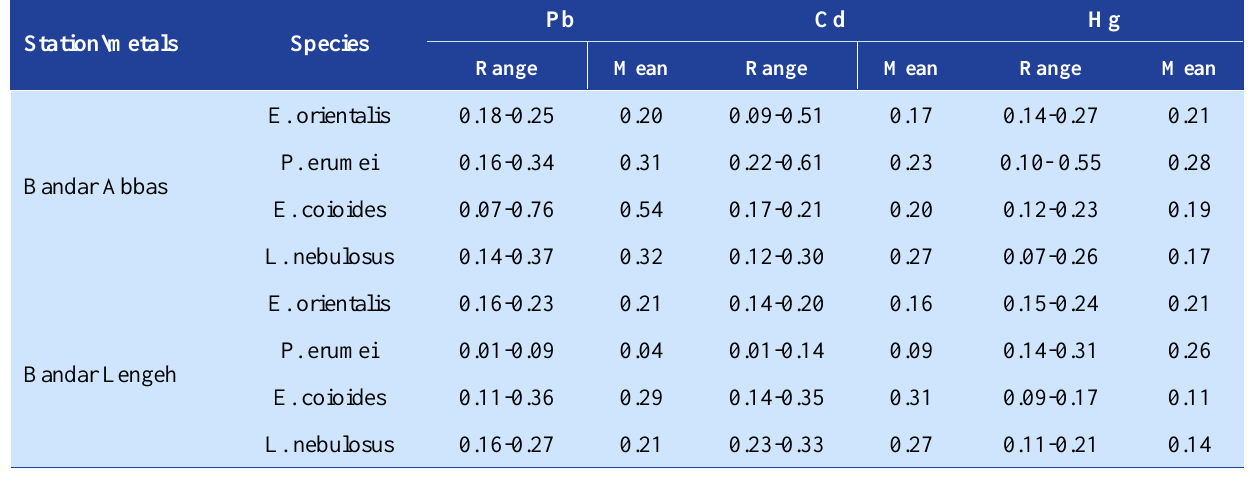
Table 3. Average concentrations of heavy metals in fish species (µg/g dry weight)